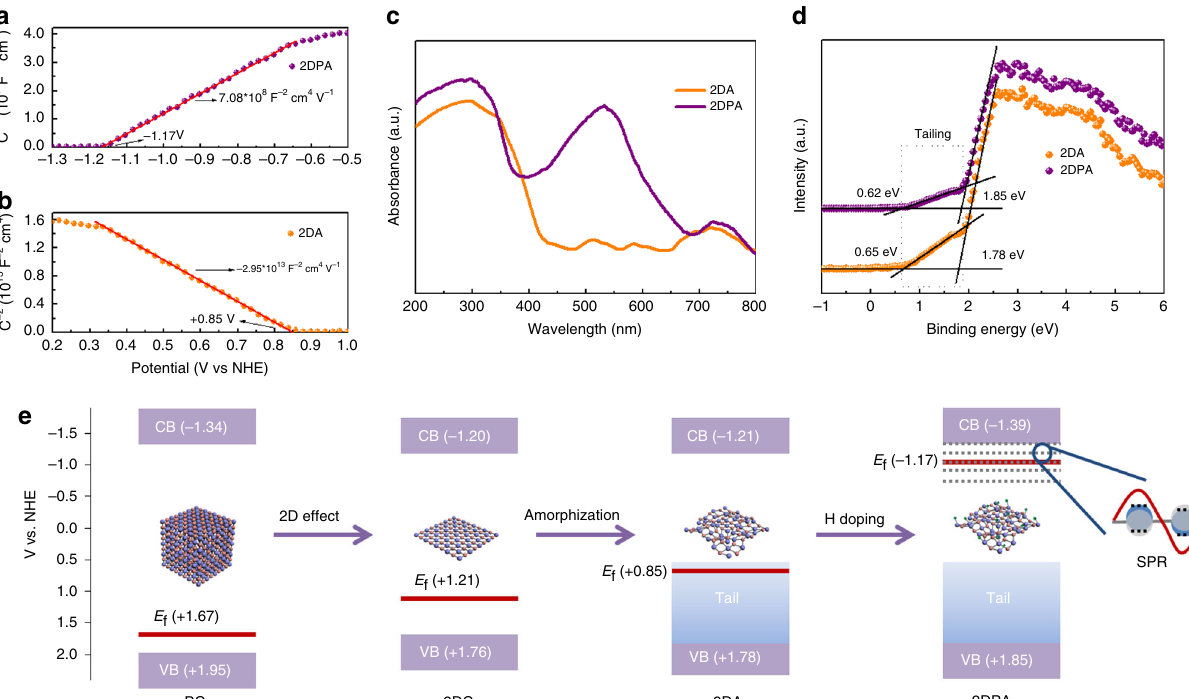
Fig. 2 Electronic structures based on spectral characterizations. a , b Mott-Schottky plots of 2DPA ( a ) and 2DA ( b ). V is the applied bias at the electrode, and C is the obtained capacitance. c , d Absorbance spectra, VB XPS spectra of 2DPA (purple) and 2DA (orange). e Schematic illustration of the band structures. The cyan lines represent Fermi levels, and the numbers above mean the Fermi level positions. The light purple bands represent CBs and VBs, and the numbers inside mean the values of CBMs and